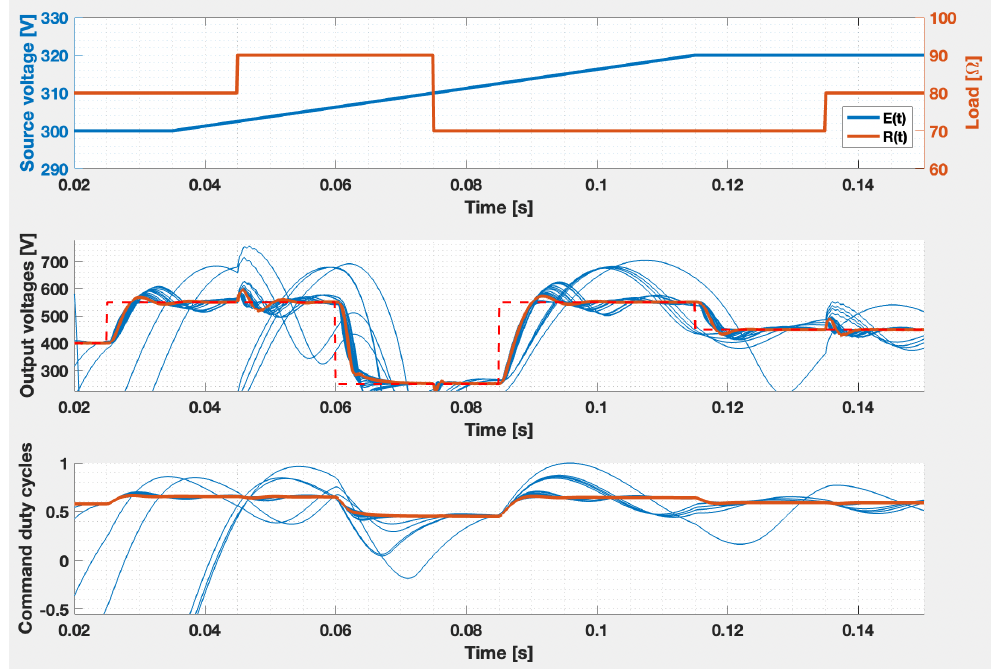
Figure 5. Average nominal bilinear DC-DC SEPIC converter model with 30 parameters sets for the = 8.9189 × 10 4 ; the first plot—exogenous K-PBC around sub-optimal values α (cid:63) = 1 × 10 − 3 , K (cid:63) 2 inputs, the second plot—reference (dotted red) and output voltage: sub-optimal (orange) versus other configurations (blue); the third plot—command signal: sub-optimal case (orange) and other configurations